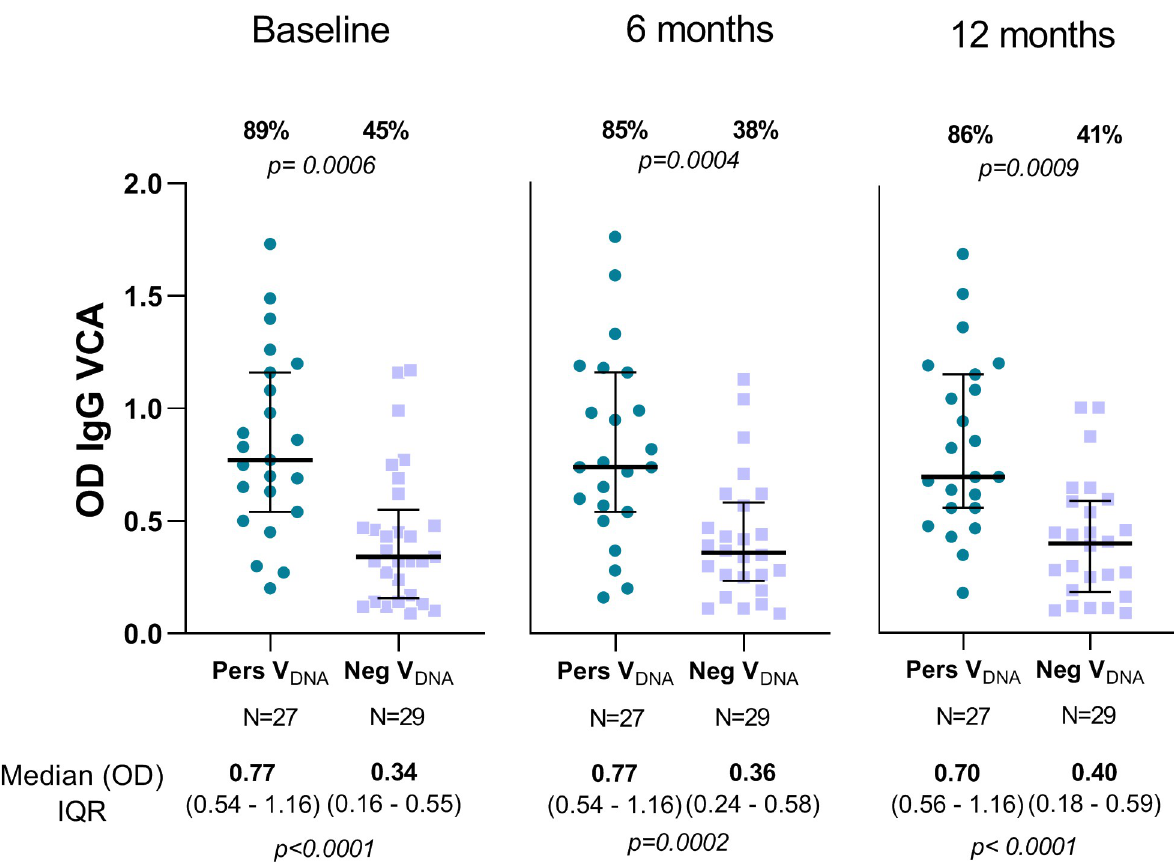
Fig 1. Profile of IgG antibody response against EBV capsid antigen p18 (VCA-p18) in individuals whose EBV-DNA could be detected (PersV DNA ) or not (NegV DNA ) over the follow-up period. For each graphic, individual datapoints were expressed as ELISA absorbance (OD) and shown here as a scatter dot plots with lines showing the median with interquartile range (IQR). Numbers represented in the top and bottom of graphics represent the proportion of responders (%) and median (OD) with IQR values, respectively; p-values for significant difference between groups were included and calculated as described in methods. The proportion of responders was determined by considering an OD > 0.38 as ELISA-positive response (S2 Fig). All raw data are available in the S1